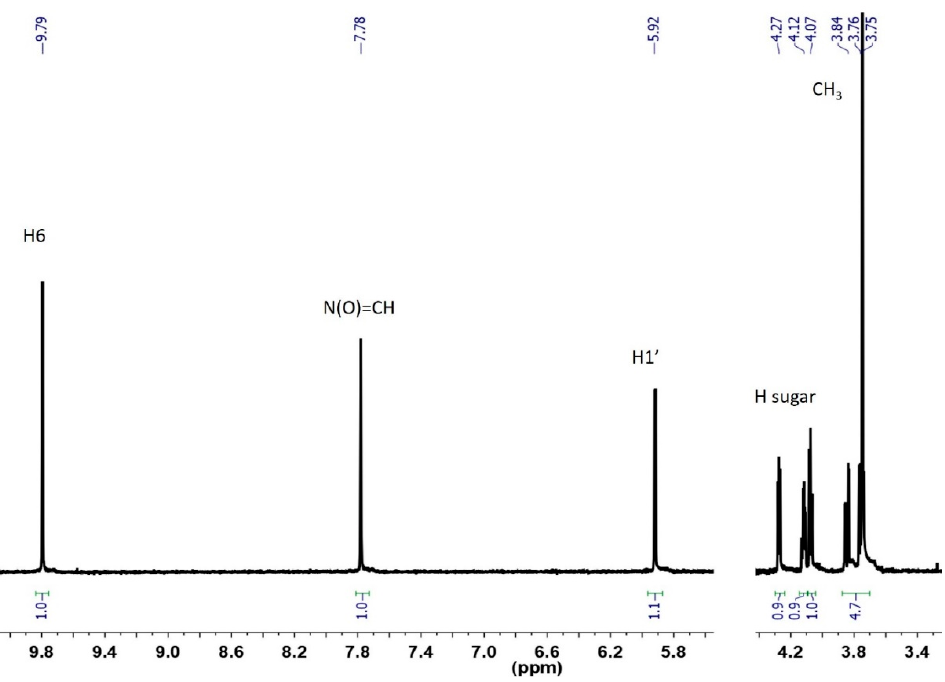
Figure 3. 1 H-NMR (600 MHz) spectrum of 1 in D 2 O at 298 K.